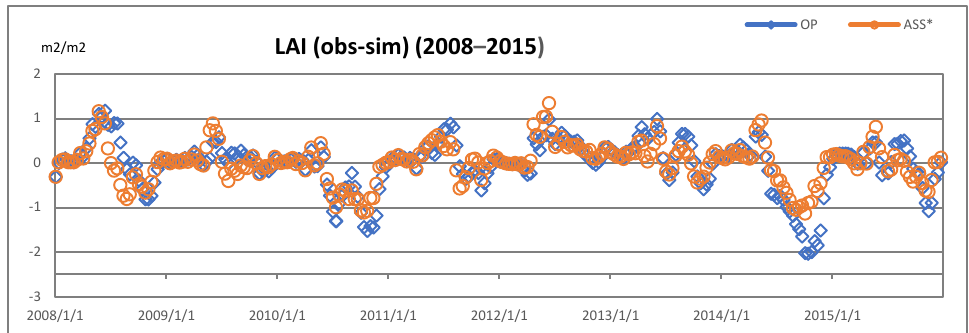
Figure 6. Time series of the residuals, SAT-OP: blue, SAT-ASS*: orange.